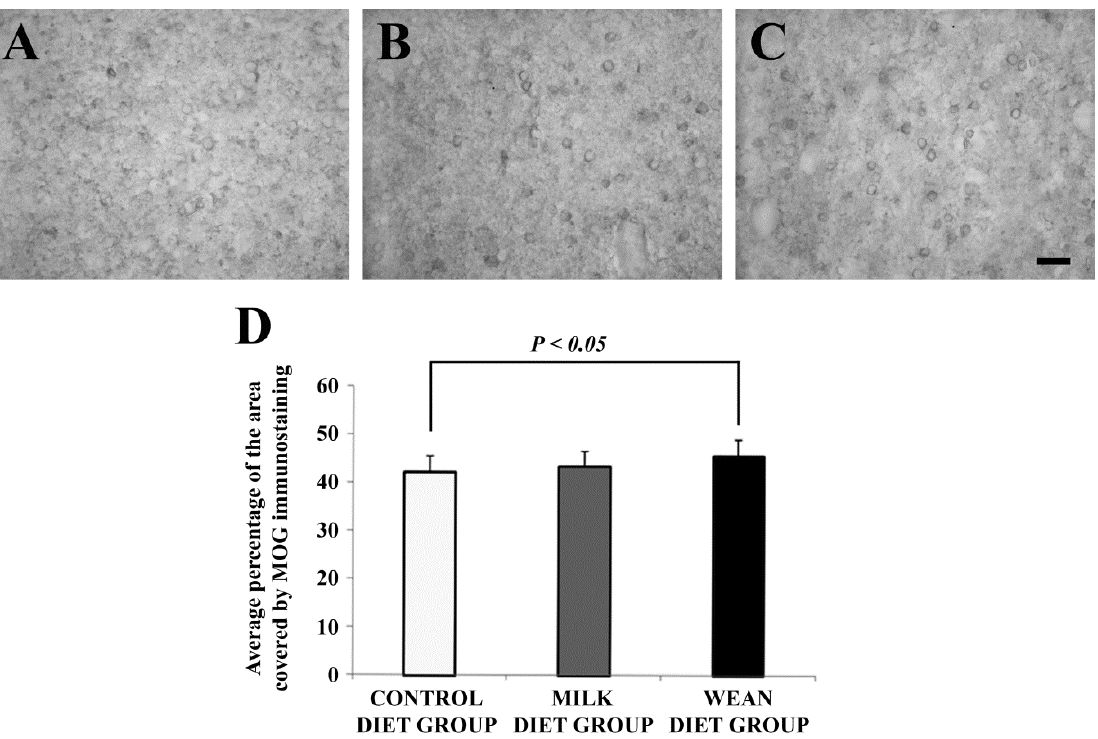
Figure 3. Brightfield photomicrographs of coronal sections ( A – C ) and histogram ( D ) showing the distribution of myelin oligodendrocyte glycoprotein (MOG) immunoreactivity in the prefrontal cortex of the control diet group ( A ), milk diet group ( B ), and wean diet group ( C ). Note that the percentage of the image covered by MOG immunoreactivity ( D ) is significantly higher in wean diet group than in control diet group. Scale bar = 20 µm in C (applies to A – C).